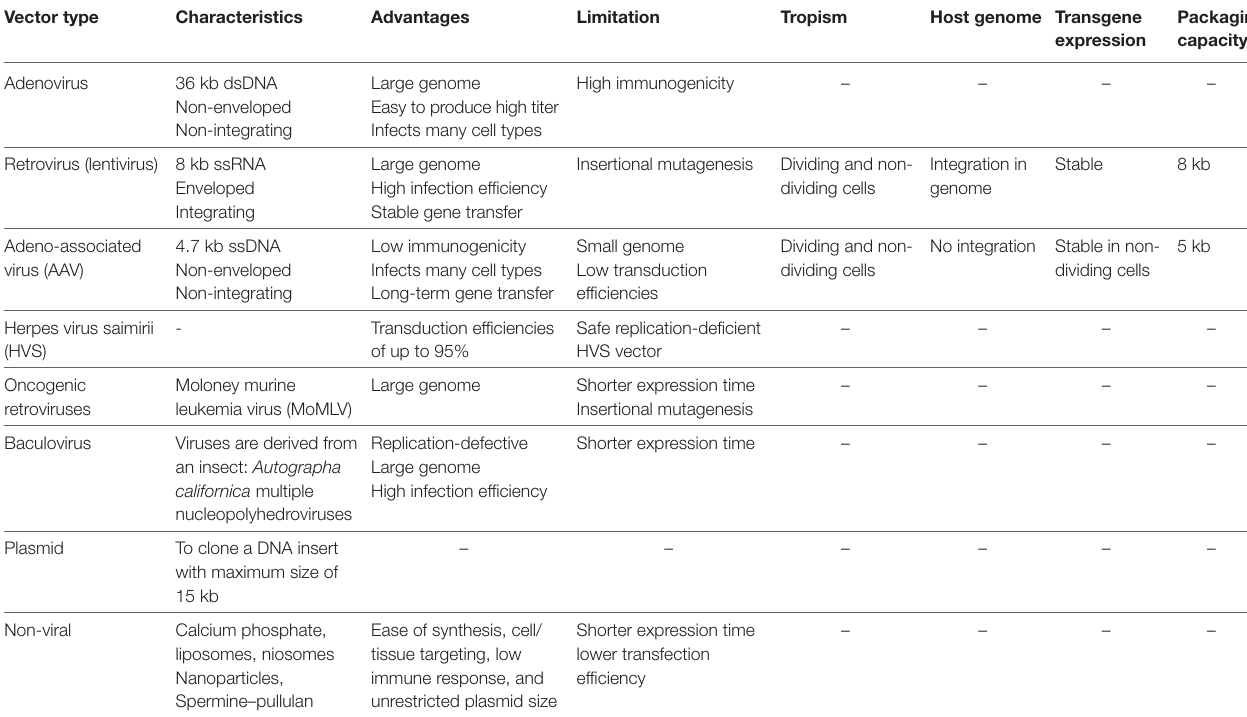
TABle 3 | The features, advantages, and disadvantages of the most used viral and non-viral vectors for gene transferring into the target cells (65–78). vector